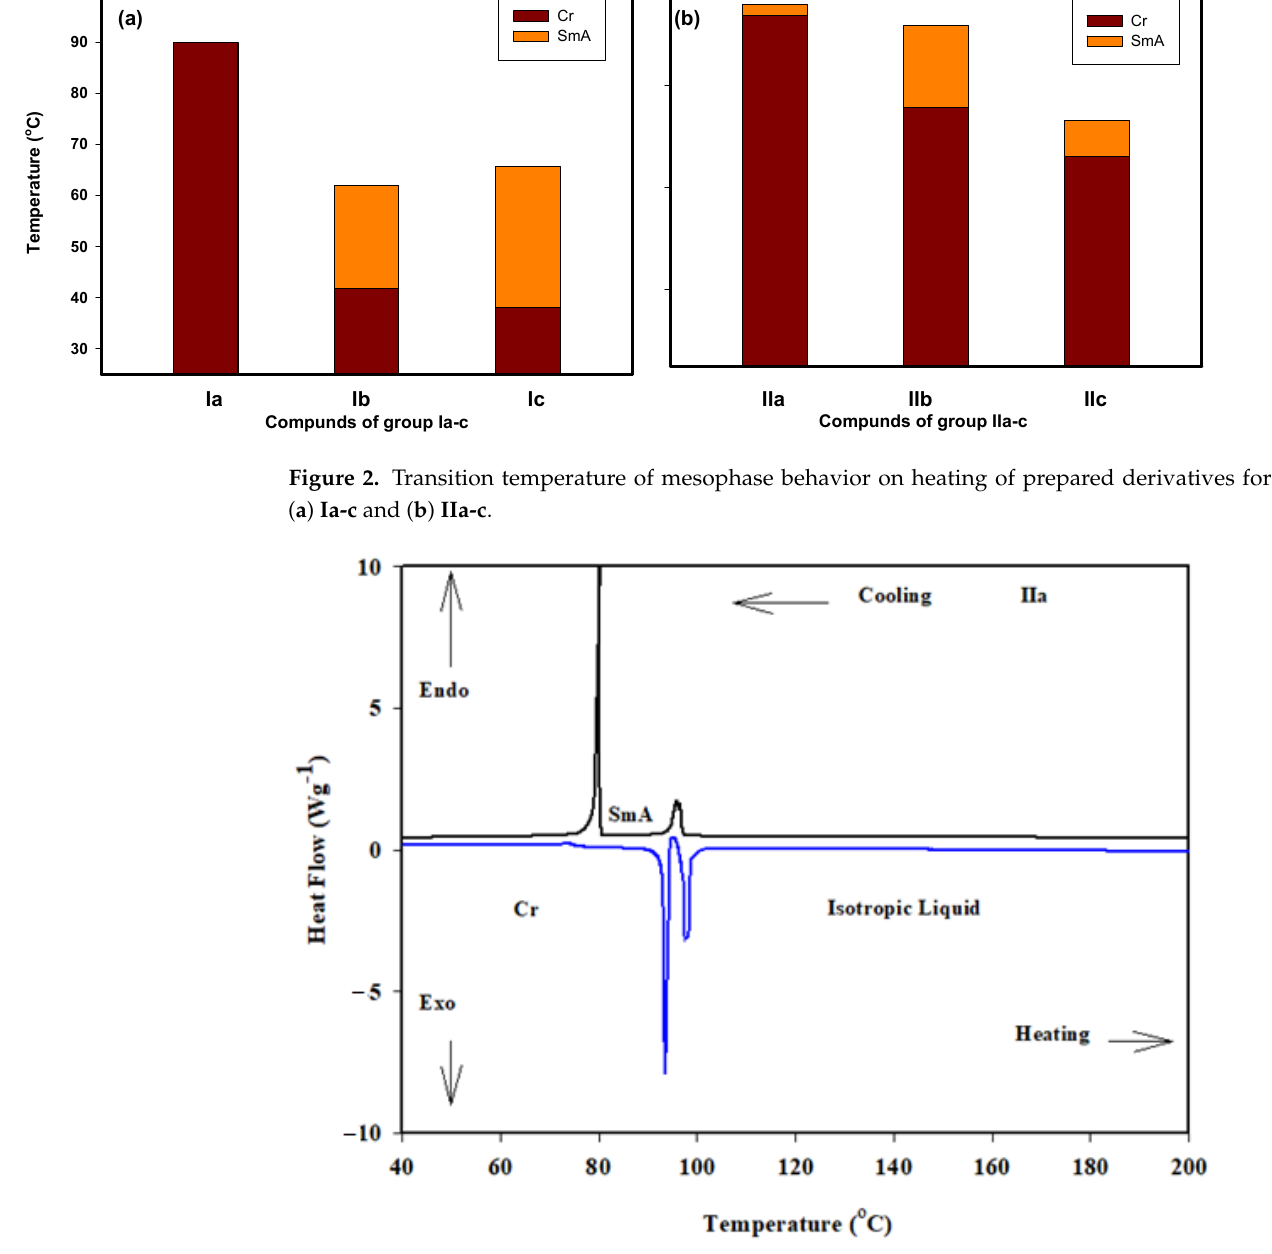
Figure 3. DSC thermograms of IIa derivative recorded from second heating and cooling at a rate of 10 o C min − 1